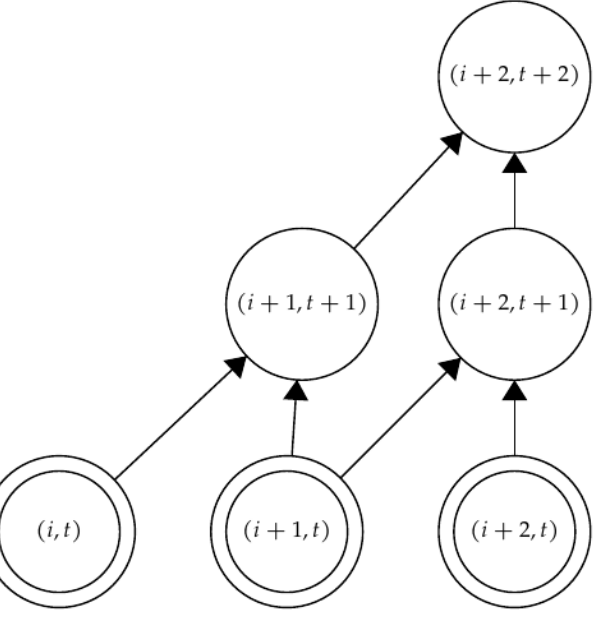
Figure 4. A ring (double circle) indicates the primary vertices. There are three secondary vertices, forming a pyramid.